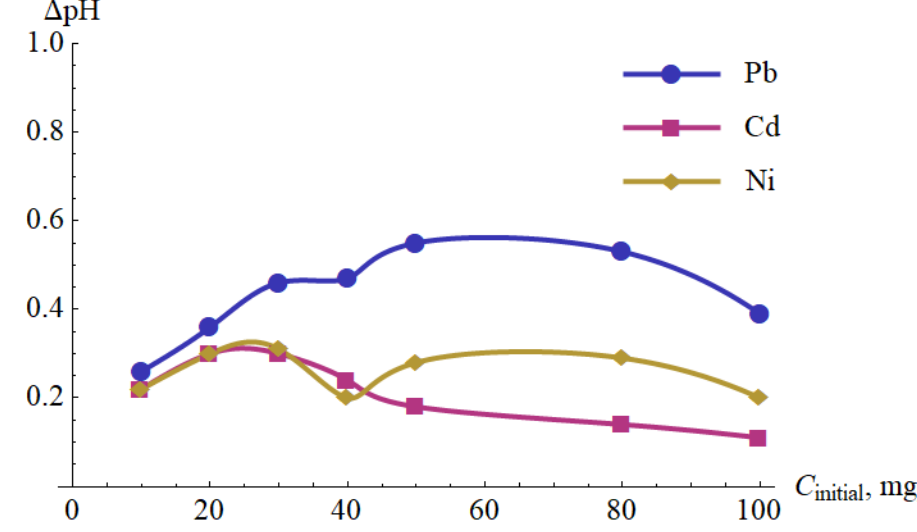
Figure 11. pH increase of the Pb(II), Ni(II) and Cd(II) aqueous solutions versus the initial concentration before the exposure to cold plasma and after one cycle of exposure. The energetical efficacy of the metal ions removal after one pass is presented in Figure 12. In the considered range of the concentrations of metal ions, the efficacy is approximately proportional to the initial concentration.